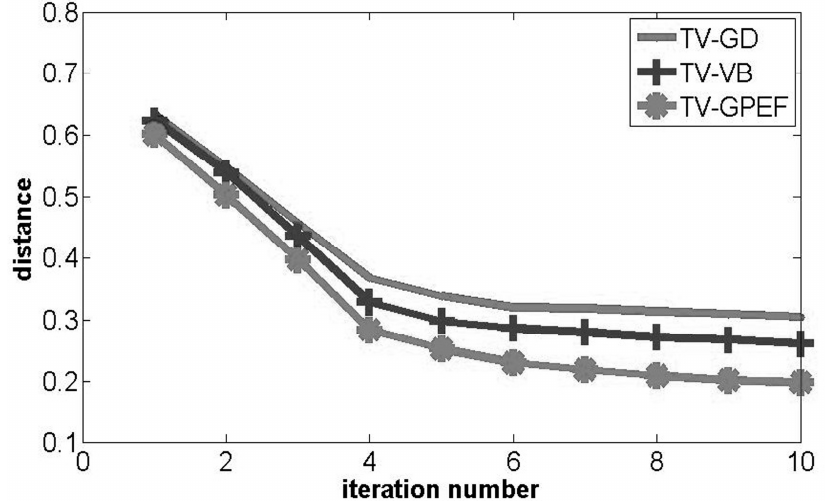
Figure 10. The line chart of the distance between the reconstructed image and the original image for each iteration from the TV-GD, TV-VB and TV-GPEF algorithms.